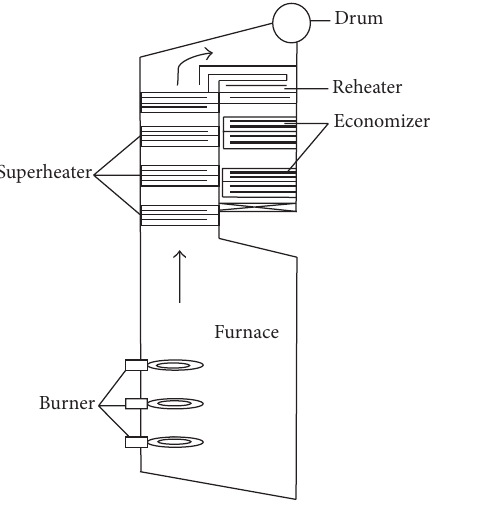
Figure 2: Overview of boiler. Table 1: Plant operation at 100% load and fuel characteristic.